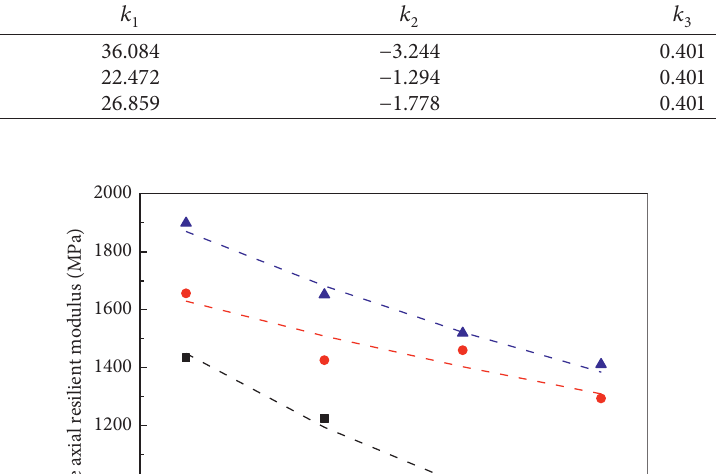
Table 4: Regression parameters and R 2 for axial resilient modulus predictive models.